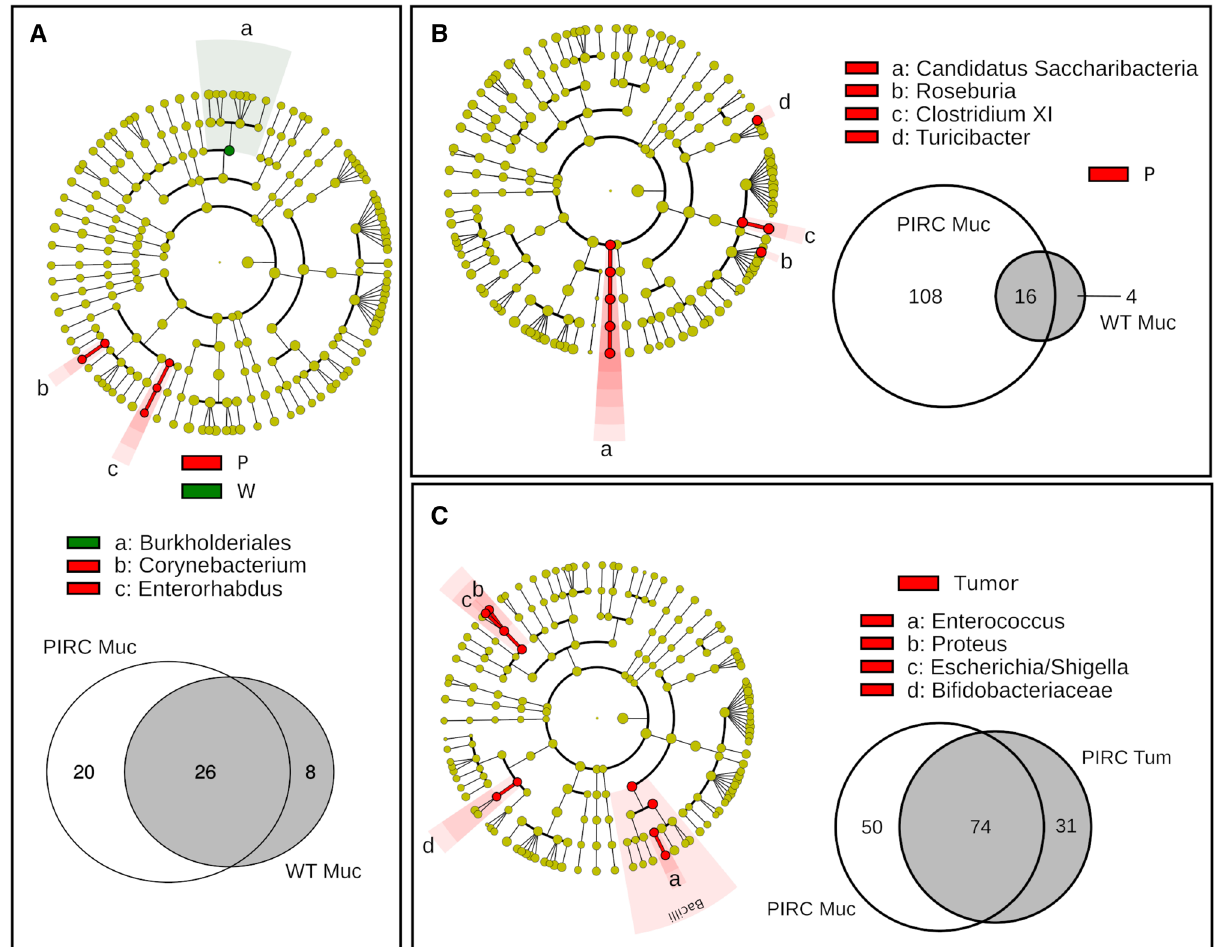
Figure 5. LEfSe and “core microbiota” on mucosa adherent bacterial communities at T1 ( A ) and T11 ( B ), and in comparison with tumour adherent bacterial communities ( C ). Cladograms show the most discriminative bacterial clades. Coloured regions/branches indicate differences in the bacterial population structure between the different genotypes (Pirc and wt, ( A,B )) and between the different tissues in Pirc rats (Mucosa vs Tumour, ( C )). Statistically significant taxa enrichment among groups was obtained with Kruskal–Wallis test among classes (Alpha value = 0.05). The threshold for the logarithmic LDA score was